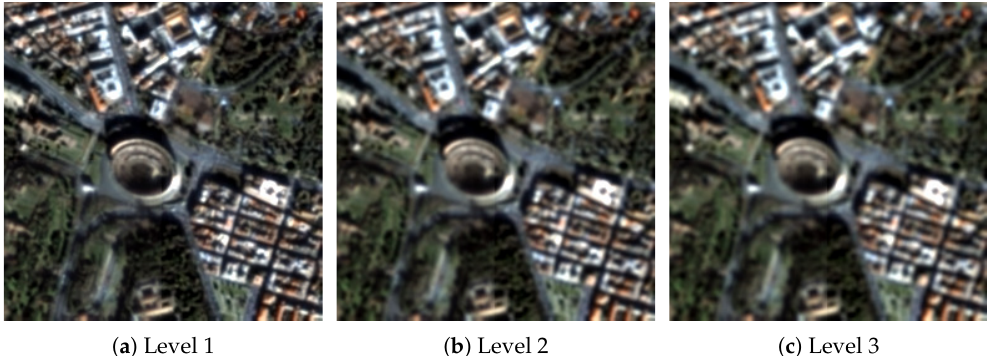
Figure 2. Example of distortion levels. Three different levels of distortion for ( a – c ) blur.